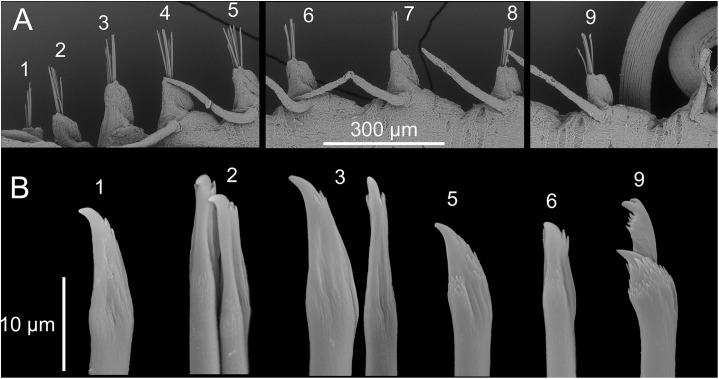
Proceraea exoryxae sp. nov. SEM micrographs of chaetae structure [MNCN 16.01/17719].(A) Chaetigers 1–9. (B) Chaetae: 1–3, simple chaetae with long region distal to the swollen neck from chaetigers 1–3; 5–6, simple chaetae with short region distal to the swollen neck from chaetigers 5 and 6; 9, compound chaetae from chaetiger 9.